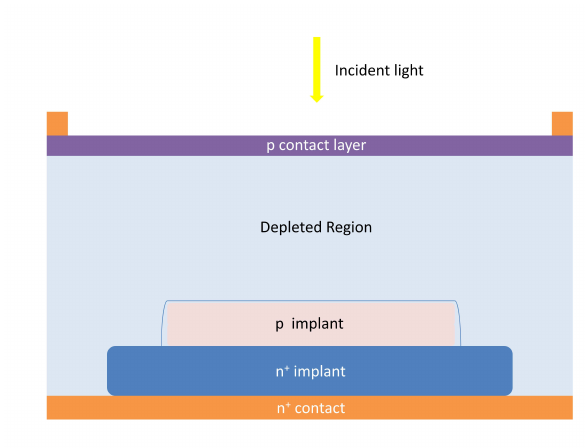
Figure 6: Reach-through APD with an n + /p multiplication region and an ultralow-doped absorption region. From [40].